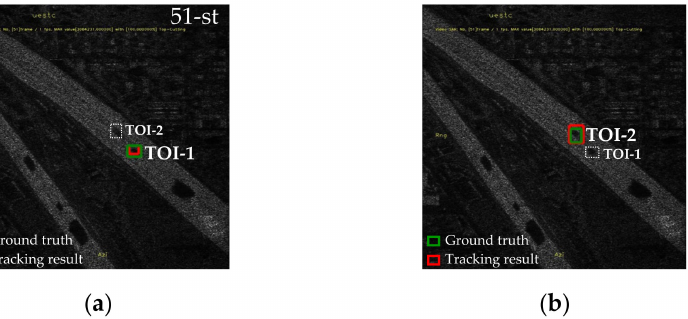
Figure 16. Tracking results with distractors: ( a ) TOI-1 in the 51st frame of Video 6; ( b ) TOI-2 in the 51st frame of Video